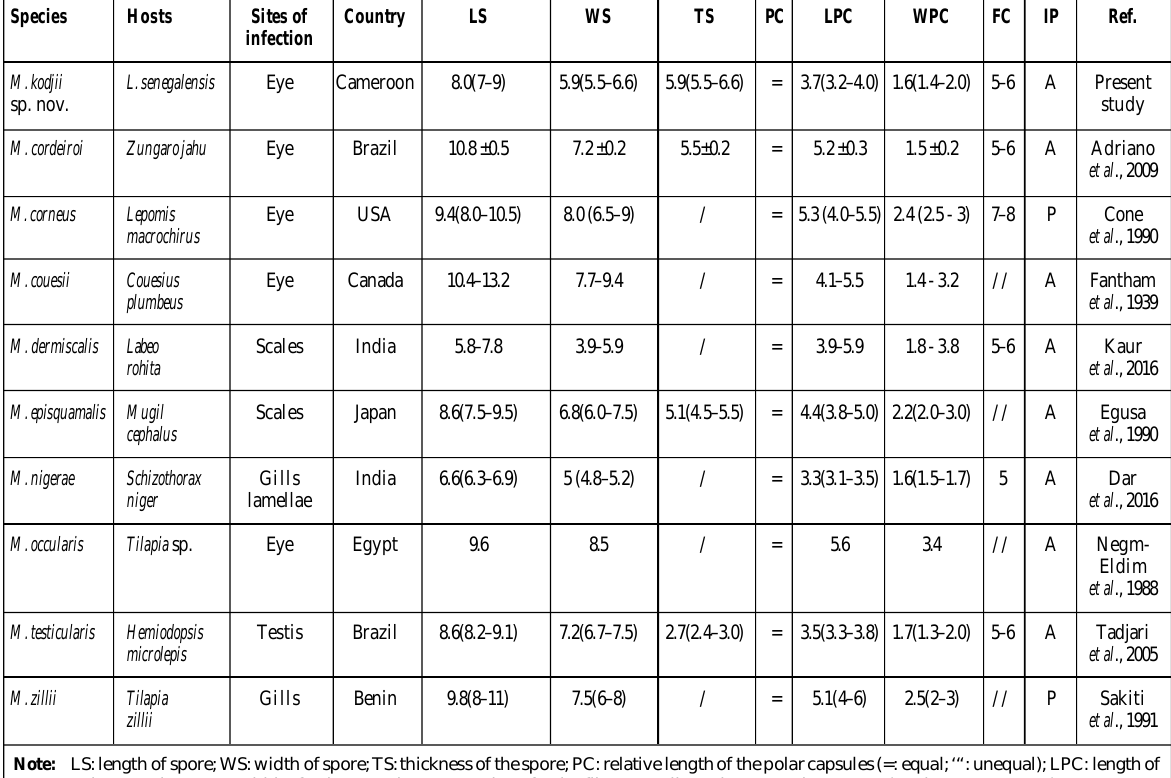
Table 1: Comparative description of Myxobolus kodjii sp. nov.with morphologically similar species (measurements in micrometer)